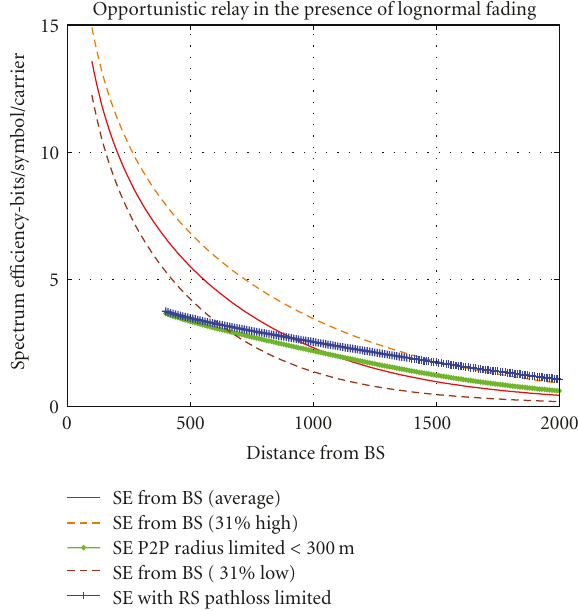
Figure 4: SE for opportunistic relay in the presence of lognormal fading.